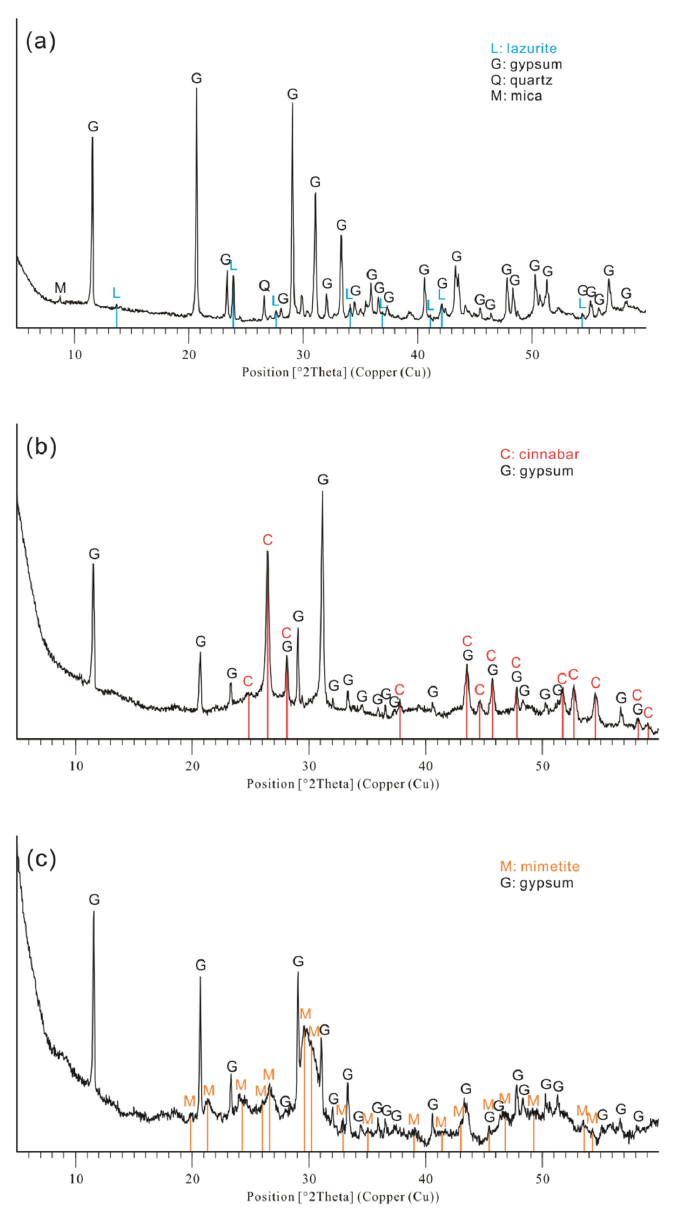
Figure 4. X-ray diffraction patterns of ( a ) blue pigment, ( b ) red pigment, and ( c ) black pigment. In the case of the black specimen, the diffraction pattern of mimetite, a mineral containing lead, was recorded, as shown in Figure 4c. This mineral has reportedly been used as a yellow and yellow-brown pigment in Central Asian and Egyptian cultures